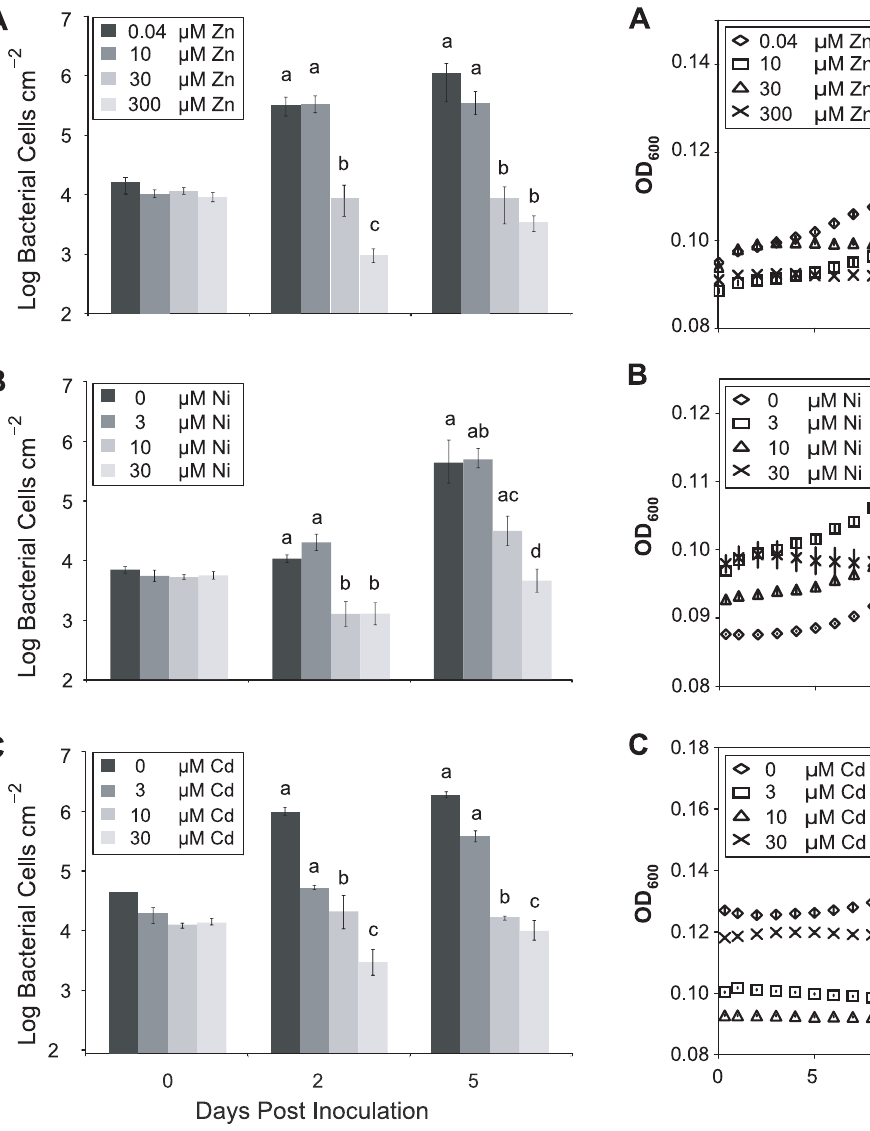
Figure 3. High metal concentrations inhibit bacterial growth in Thlaspicaerulescens . T. caerulescens plants were treated with a range of zinc ( A ), nickel ( B ), or cadmium ( C ) concentrations. Nine leaves of each of six plantswere infiltrated with P. syringae pv.maculicolaM4 suspended in 10 mM MgCl 2 at 10 6 cfu/ml and leaves sampled at 0, 2 and 5 days after inoculation. Six samples were taken per time point and treatment, each sample consisting of three leaves pooled from one plant. Plant zinc, nickel and cadmium treatments were significant predictors of Psm growth at both day 2 and day 5 (ANOVAs; P , 0.0005). Bonferroni simultaneous comparisons were carried out; means that were not significantly different are marked with the same letter. Values are means 6 SE ( n =6). The experiment was repeated twice with similar results.